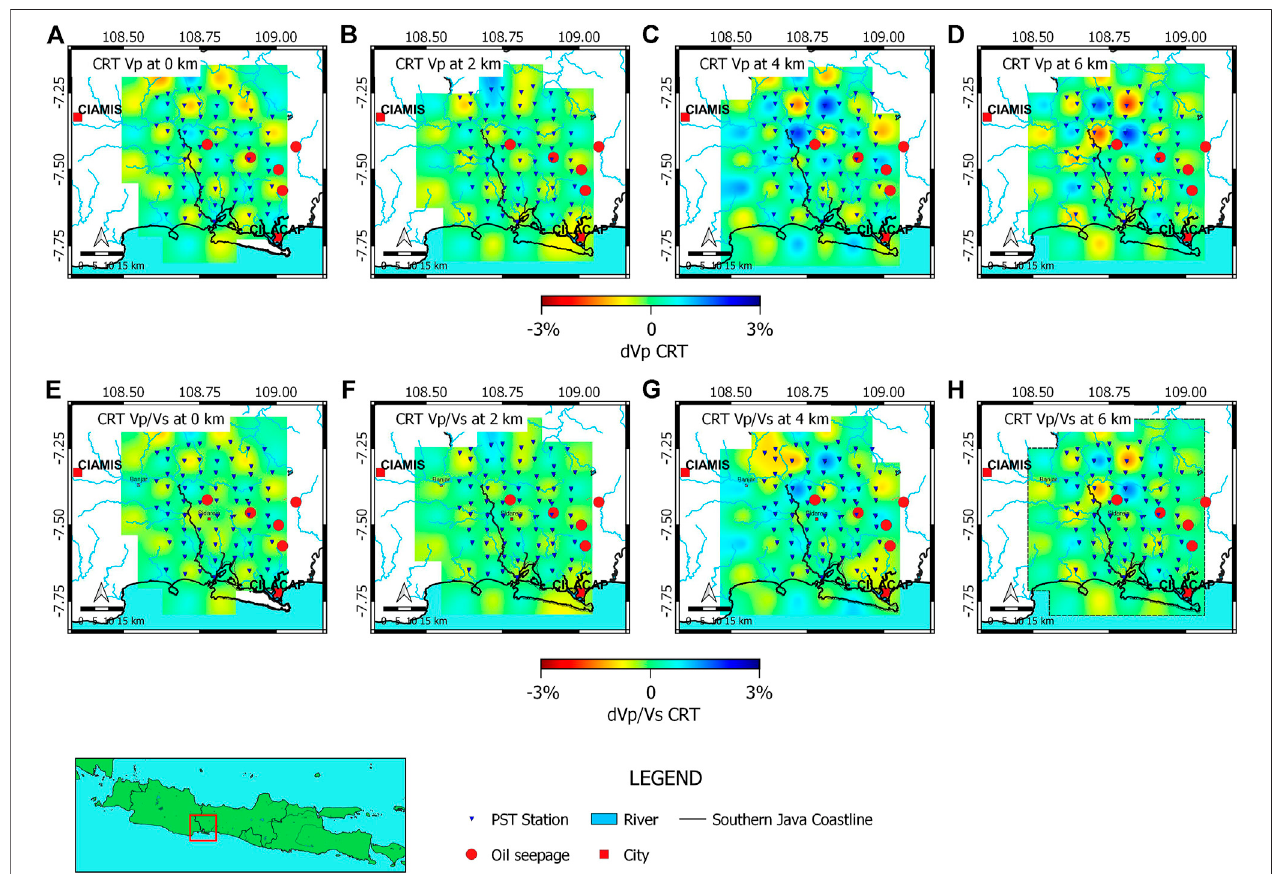
FIGURE 4 | Horizontal view of recovery from ± 10% initial checkerboard resolution tests for Vp and Vp/Vs ratio. Figure (A – D) are recovery of the Vp checkerboard test at 0 – 6 km depth, while fi gure (E – H) show recovery of the Vp/Vs checkerboard test at 0 – 6 km depth. Blue and red colors indicate positive and negative anomalies, respectively. Random noise with a 0.1 s standard deviation was added to the synthetic travel